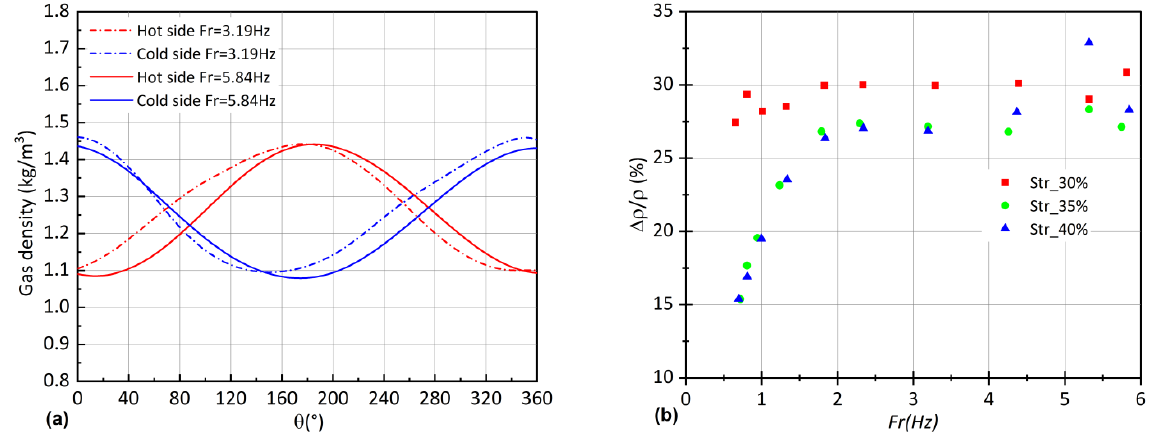
Figure 10. Effect of frequency on gas density. ( a ) Evolution of the gas density of regenerator Str_40% versus phase angle. ( b ) Density variation ratio versus the frequency of each regenerator ( L 1 = 60 mm, C 1 = 64.4 mm, for isothermal flow).